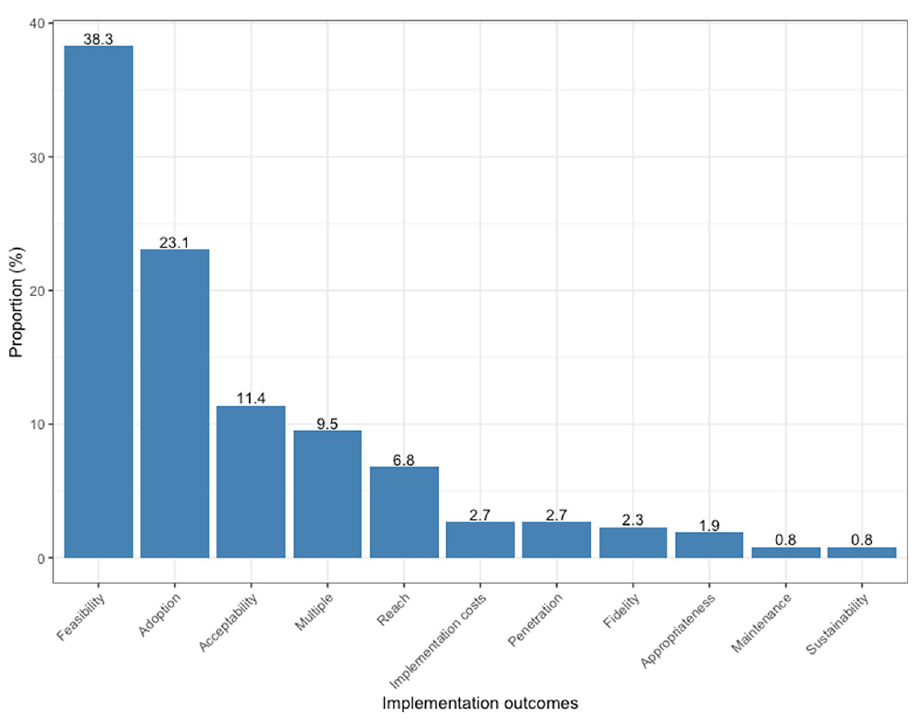
Fig 6. Distribution of implementation outcomes.